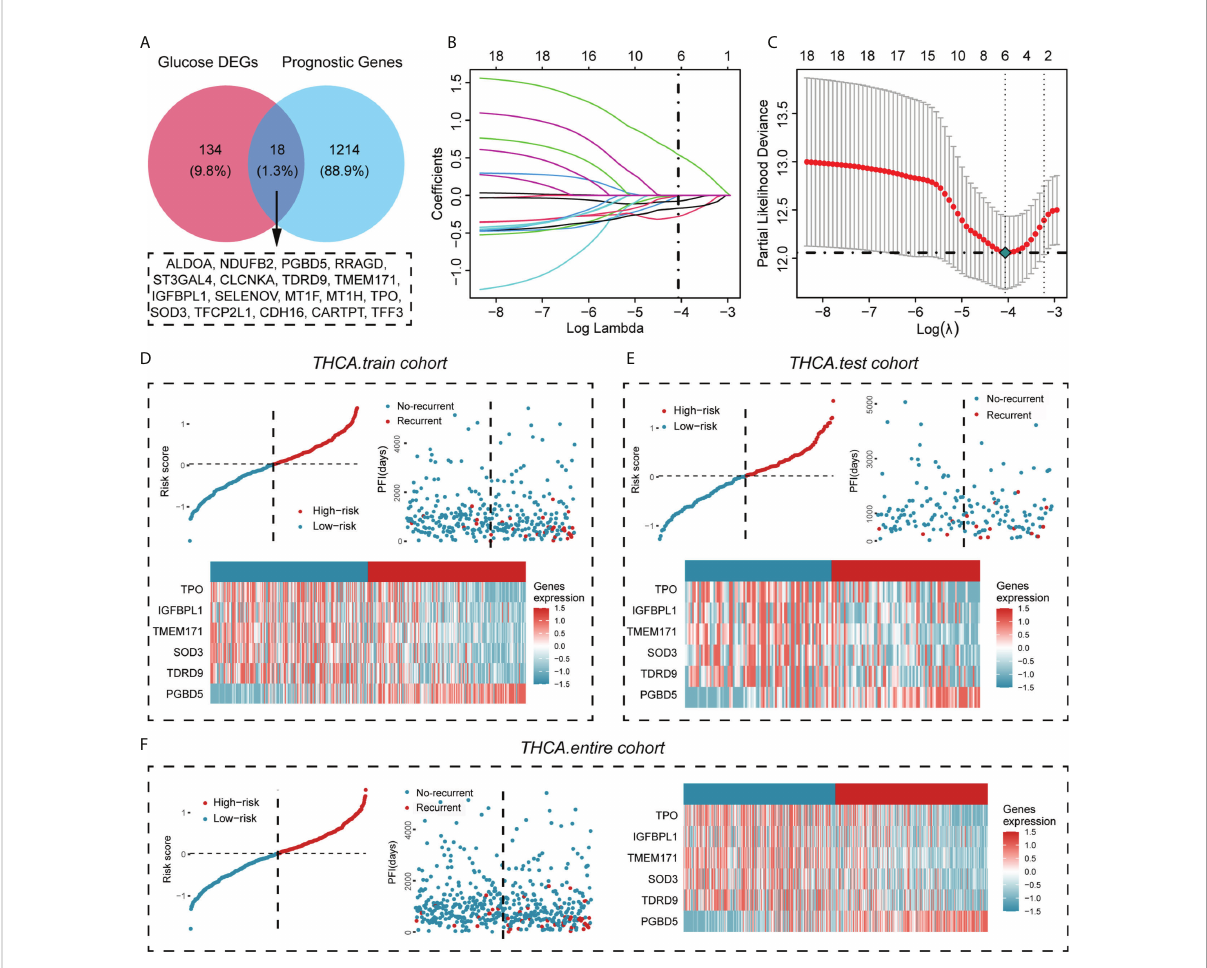
FIGURE 2 Screening for glucose metabolism-related genes highly associated with PFI and construction of a prognostic prediction model for PTC. (A) The genes associated with the PFI of PTC were obtained from the TCGA cohort (unicox P < 0.05) and overlapped with glucose metabolism DEGs, resulting in 18 genes associated with the PFI of PTC. (B) LASSO coef fi cient pro fi les of the prognostic value. (C) Partial likelihood distribution with the corresponding l -logarithm value. (D – F) The distribution of risk scores for the three data cohorts (training cohort, test cohort and entire cohort), the recurrence and nonrecurrence PFIs of the three data cohorts and the heatmap of the expression of six prognostically relevant genes related to glucose metabolism in the High- risk and Low-risk